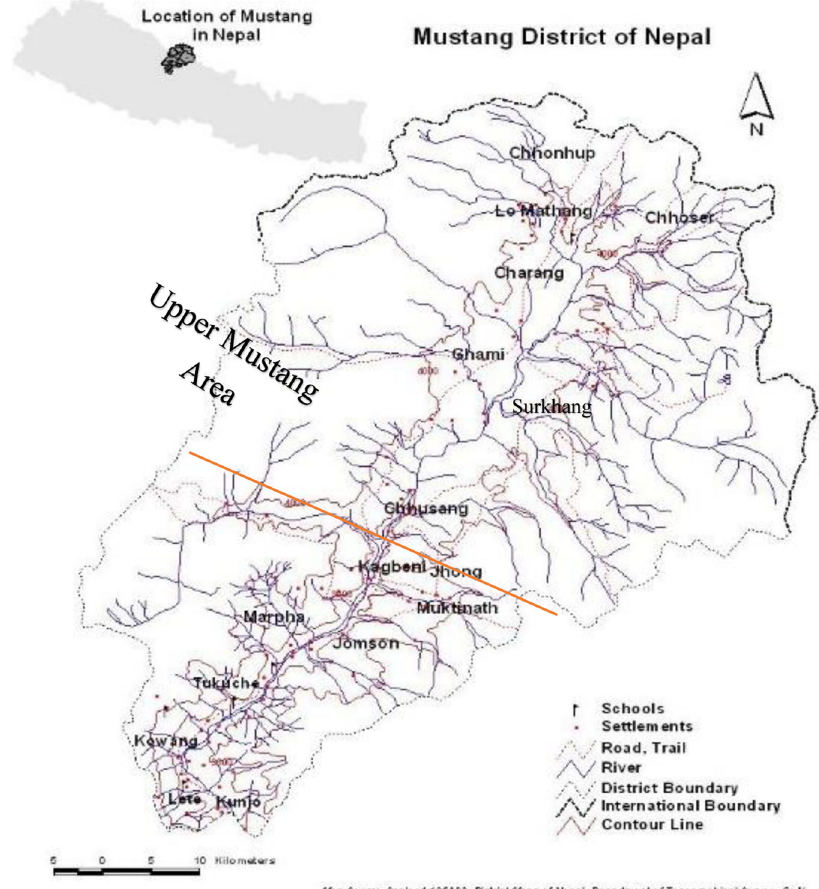
Fig. 1 Map of Upper Mustang,